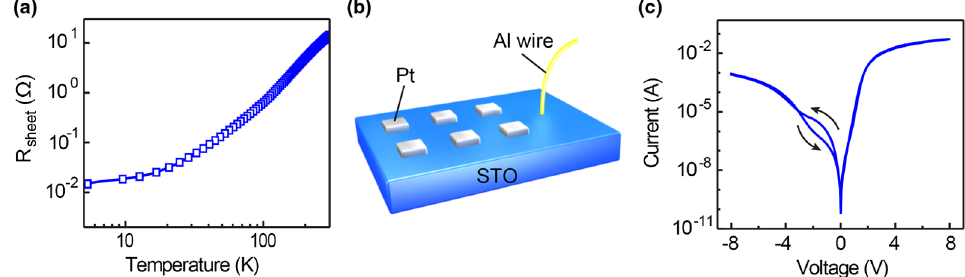
FIG. 4. (a) Sheet resistance vs temperature data measured on the reduced STO substrate. (b) Configuration of a device that has the same types of metal contacts but without the LAO layer. (c) Current (absolute values) vs voltage loop measured on the device. Even though the voltage scanning range is larger than what is used in the measurements of Pt/LAO/STO heterostructures, there is negligible hysteresis.